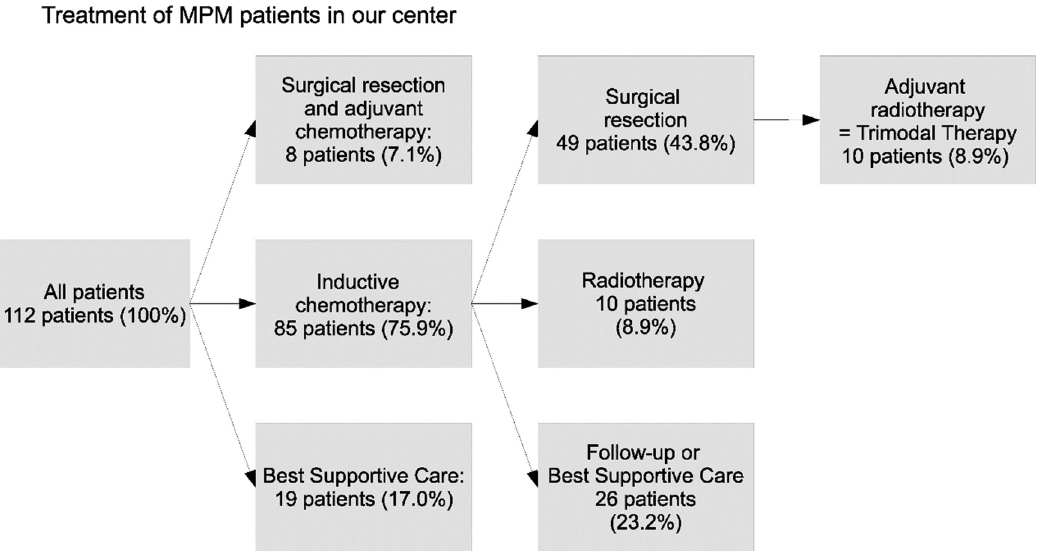
Figure 2. Treatment of MPM patients in our institution. In total, 112 patients were analyzed. Best supportive care also included all patients who did not receive chemo- or radiotherapy after a diagnostic VATS or debulking. MPM malignant pleural mesothelioma, VATS video-assisted thoracoscopic surgery. Table 2. Comorbidities in the whole cohort. The p -values and hazard ratios were determined by univariate Cox regression. NIDDM non-insulin-dependent diabetes mellitus, statistically significant p -values were printed in bold. EPP